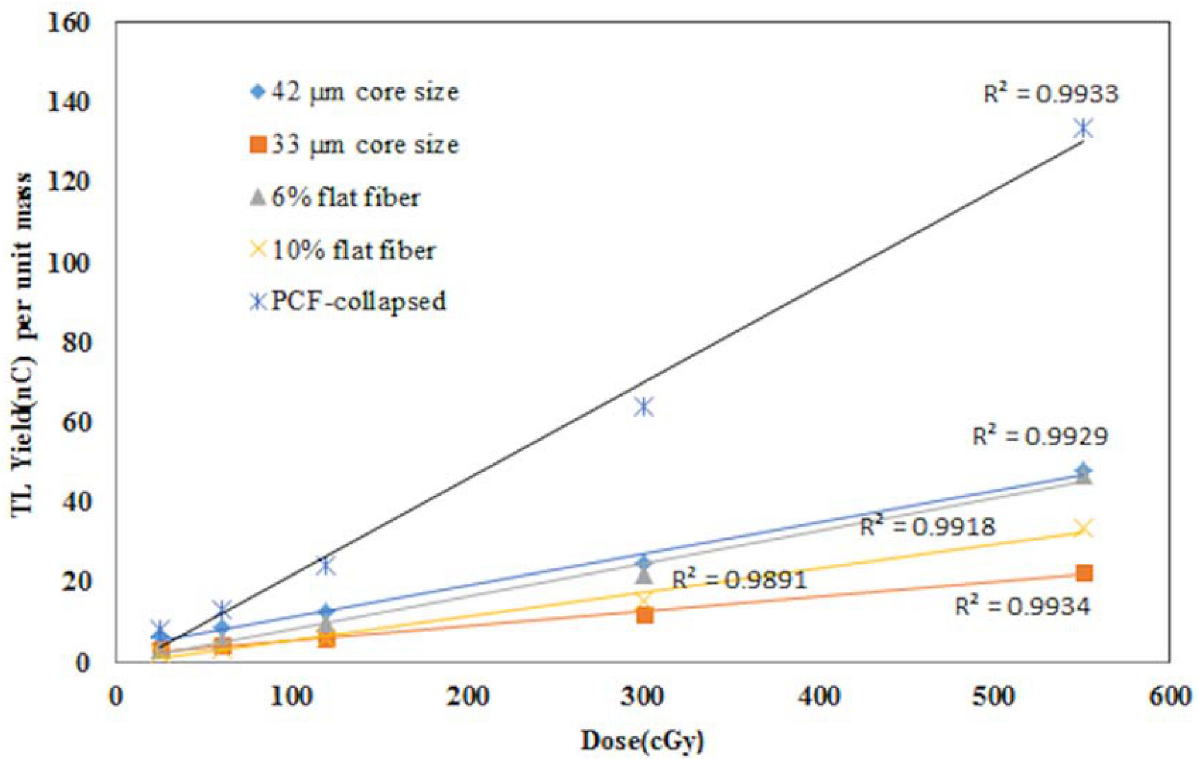
Fig 6. Comparison of dosimetric response for PCF-collapsed cylindrical and flat fibres. Figure shows the dosimetric response for PCF-collapsed.10% Ge-doped (33 & 42 μ m core diameter cylindrical fibres) and flat-fibres (6 & 10% Ge-doped), irradiated with 6 MV photons for doses from 25 – 550